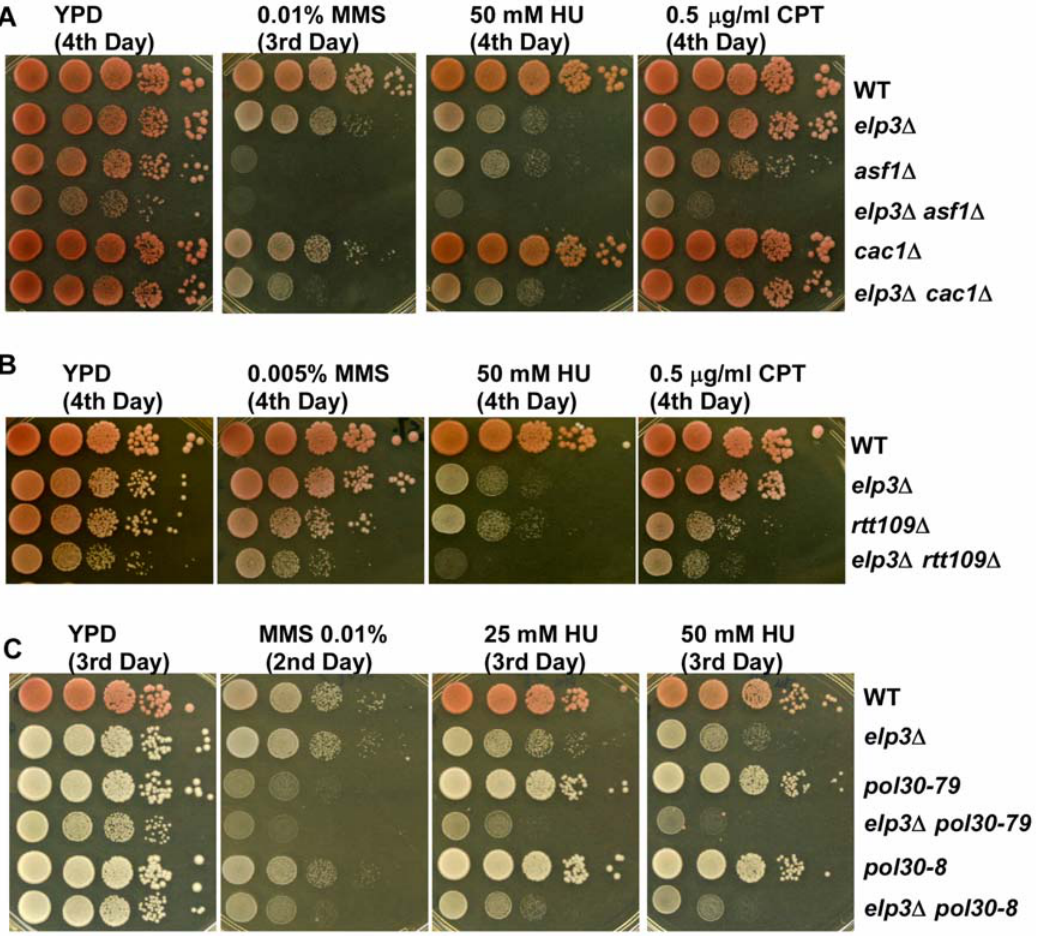
Figure 5. Elp3 is important to resist DNA damaging agents in the absence of Asf1 and Rtt109, two proteins that are essential for acetylation of lysine 56 of H3 in cells. (A) Elp3 functions in a pathway that is genetically distinct from Asf1 in response to insults from DNA damaging agents. Ten-fold serial dilutions of wild type, asf1 D , cac1 D and elp3 D single, or asf1 D elp3 D and cac1 D elp3 D double mutant cells were plated on non-selective YPD medium or YPD medium containing indicated concentrations of DNA damaging agents MMS, HU and CPT. A more extensive analysis of the data is presented in Figure S2. (B) The elp3 D rtt109 D cells are as sensitive towards DNA damaging agents as elp3 D asf1 D mutant cells. The experiment was performed as described in A. A more extensive analysis of the data is presented in Figure S3. (C) The elp3 D mutant cells exhibit distinct sensitivity towards DNA damaging agents MMS and HU when combined with two different PCNA mutant alleles. The experiment was performed as described in A using strains with relevant genotype indicated at the right. A more extensive analysis of the data is presented in Figure S4. Pictures were taken after incubation at 30 u C for indicated amounts of time.